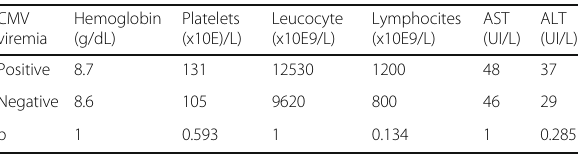
Table 1 (abstract 001114). See text for